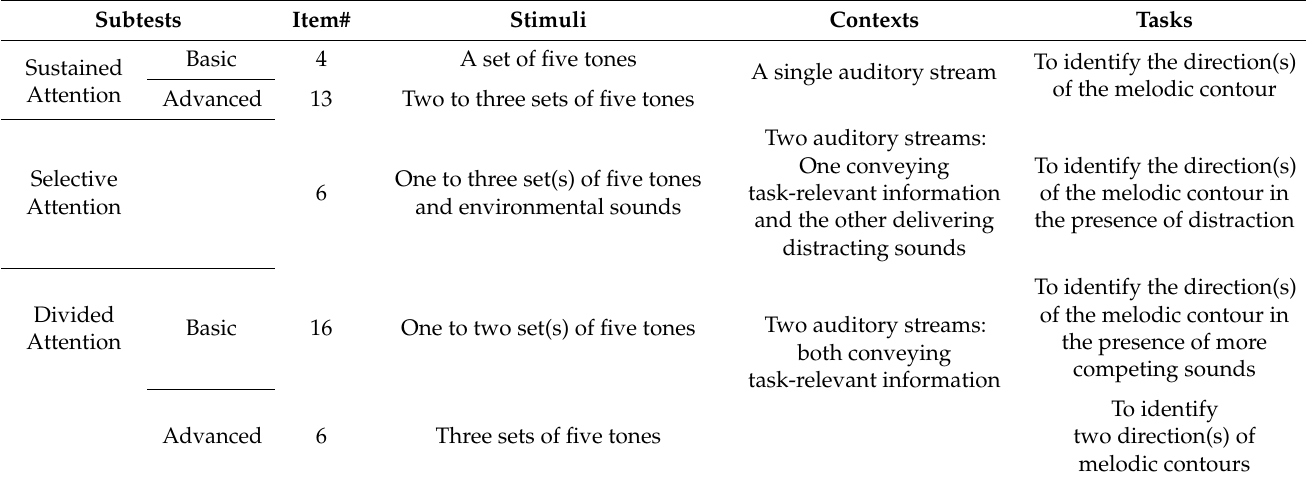
Table 2. Structure of the 45-item